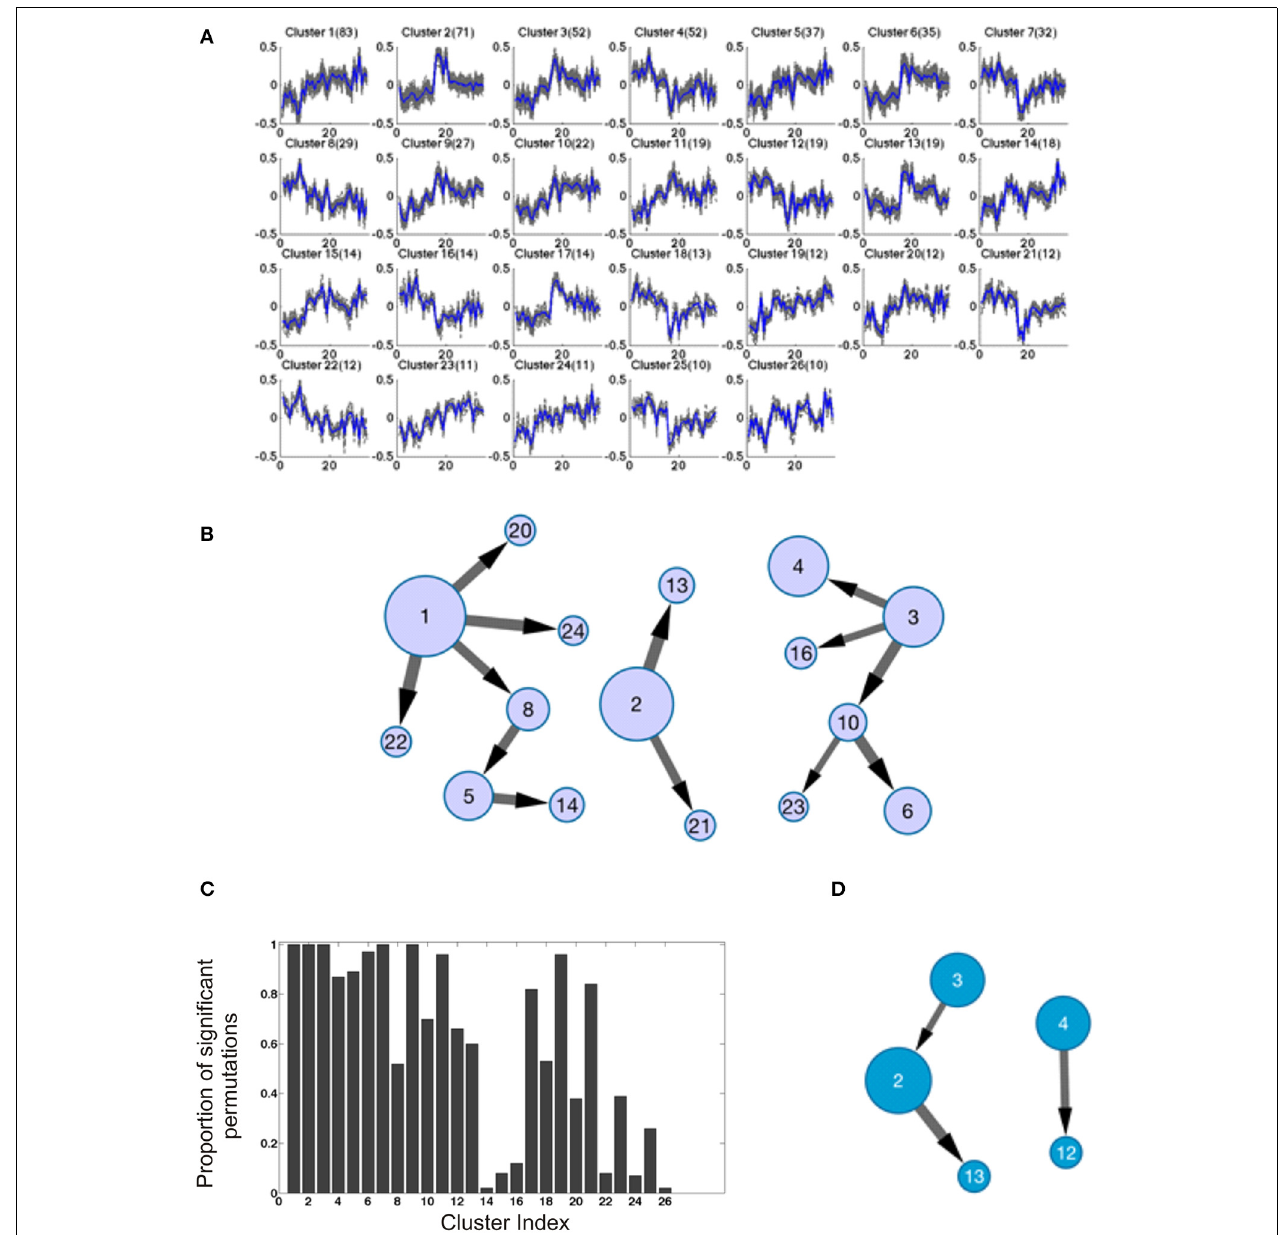
FIGURE 8 | Bayesian Network analysis. (A) The results of quality-based clustering on BM transcriptional data provide tight clusters of coregulated genes used as input for Bayesian network inference. (B) The resulting robust network, defined as those connections present in at least 50% of all subsample analyses for each of four different permutations of the dataset. The size of nodes indicates the size of the clusters (also included in A ), and the size of edges connecting nodes reflects the relative likelihood of a connection based on its overall frequency of occurrence across subsample replicates. (C) Statistical testing of the significance of correlations within